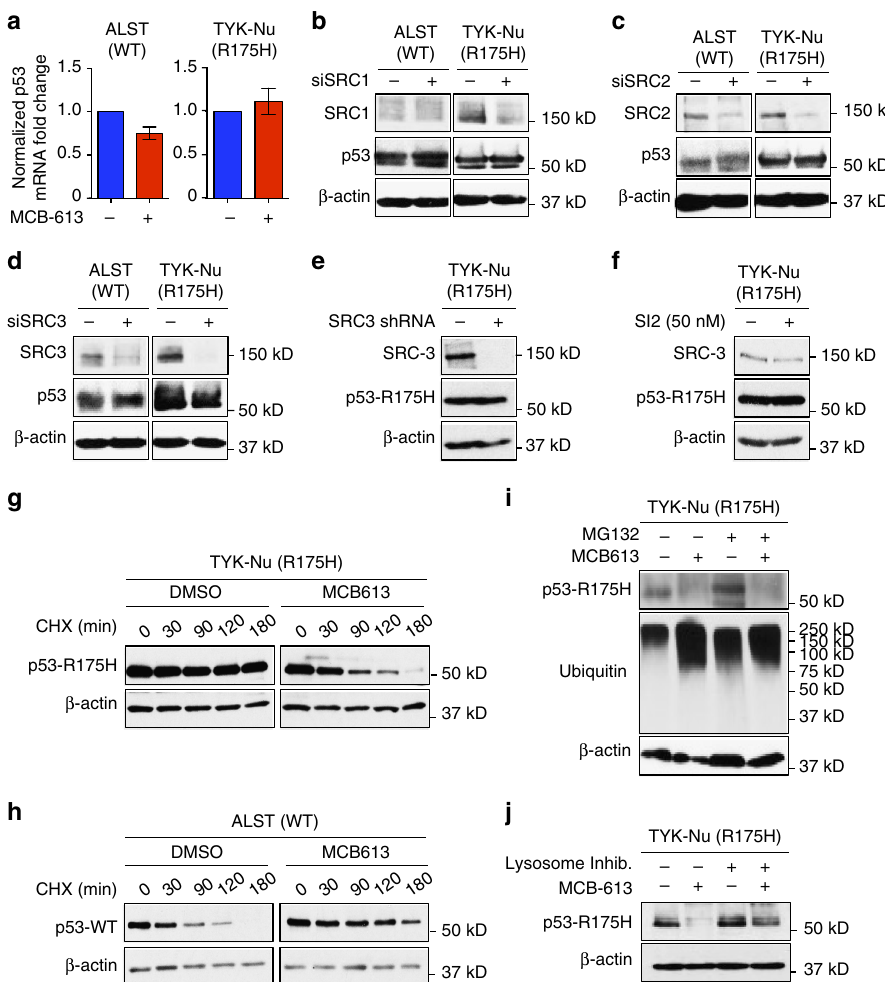
Fig. 2 MCB-613 causes lysosome-mediated degradation on p53-R175H. a Effect of MCB-613 (2 h) on p53 mRNA levels in ALST and TYK-Nu cells. Values are normalized mean ± s.e.m. ( n = 3). b – d siRNA-mediated knockdown (48 h) of SRC-1 ( b ), SRC-2 ( c ), and SRC-3 ( d ) had no effect on p53-WT (ALST cells) and p53-R175H (TYK-Nu cells) levels. e shRNA-mediated knockdown of SRC3 (72 h) in TYK-Nu cells does not affect p53-R175H levels. f SRC- 3 inhibitor SI2 (50 nM, 2 h) has no effect on p53-R175H levels in TYK-Nu cells. g , h MCB-613 caused a g decrease in the half-life of p53-R175H and h increase in the half-life of p53-WT. i Proteasome inhibitor MG132 does not inhibit MCB-613 induced turnover of p53-R175H. j Lysosome inhibitors (pepstatin A, Leupeptin, and E-64D) rescued MCB-613 induced turnover of